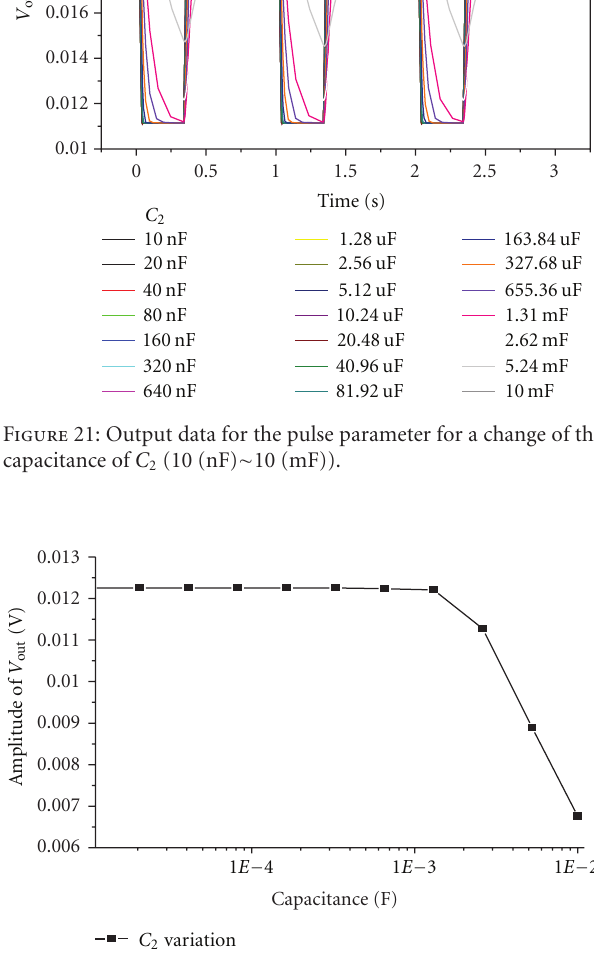
Figure 22: Response characteristic of the output voltage for the pulse parameter for a change of the capacitance of C 2 (10 (nF) ∼ 10 (mF)).